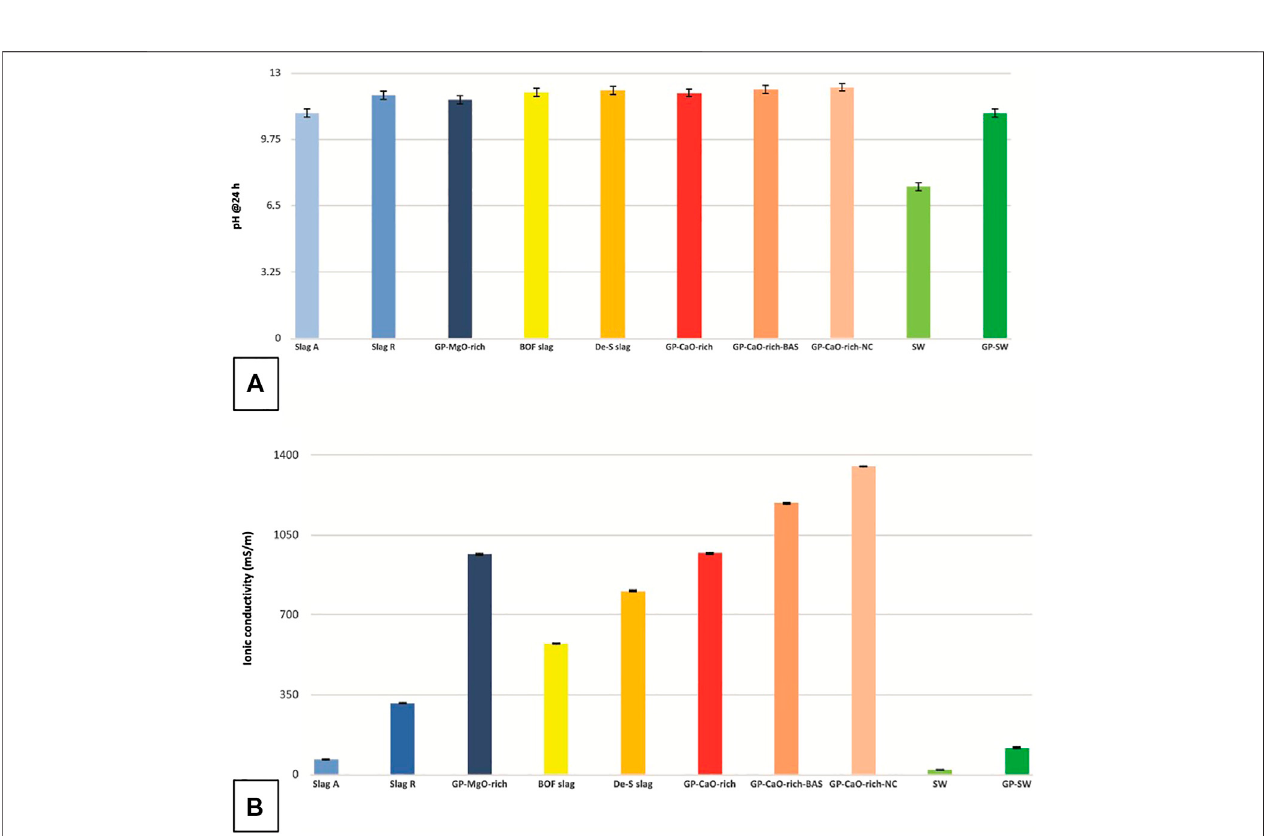
FIGURE 5 | Value of pH (A) and ionic conductivity (mS/m) (B) of the leachate after 24 h ’ immersion in fresh water. Reference value is a geopolymer produced with metakaolin.